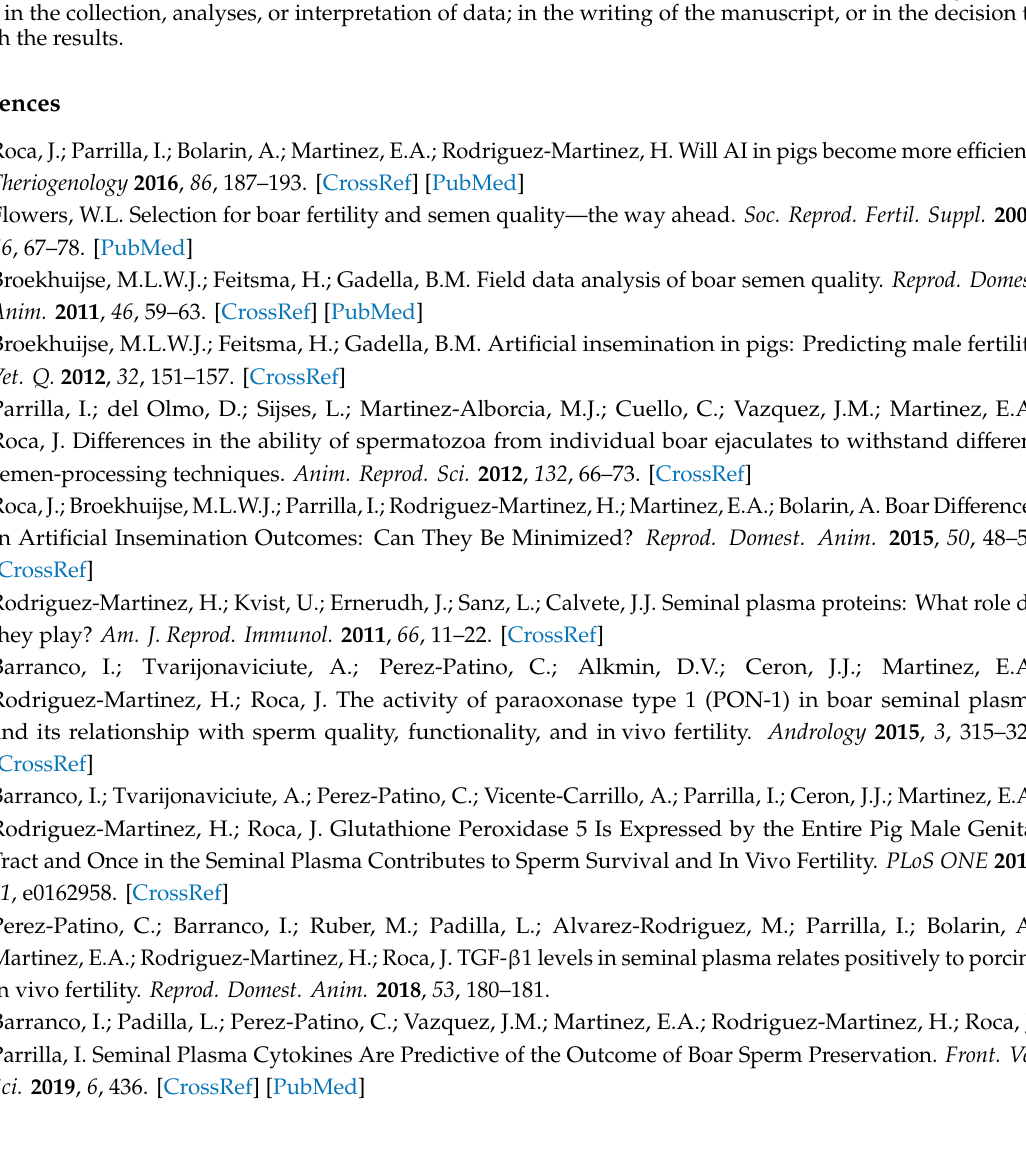
Table S1: Data of sperm viability and acrosome damage assessed in boar semen samples (n = 26) at 0 and 72 h after liquid-storage at 17 ◦ C. For flow cytometric analysis semen samples were stained with Hoechst 33342 (H-42), propidium iodide (PI) and fluorescein-conjugated peanut agglutinin (PNA-FITC). Semen samples were hierarchically grouped ( p < 0.001) as presenting low- (AMH-L; ranging from 479.92 to 701.84 ng / mL, n = 7) or high- (AMH-H; ranging from 770.53 to 1096.72 ng / mL, n = 19) seminal plasma (SP) anti-Müllerian hormone (AMH) concentration. Results are presented as the percentage (mean ± SEM) of (1) viable spermatozoa with an intact- (H-42 +/ PI- / PNA-FITC-) and non-intact-acrosome membrane (H-42 +/ PI- / PNA-FITC + )